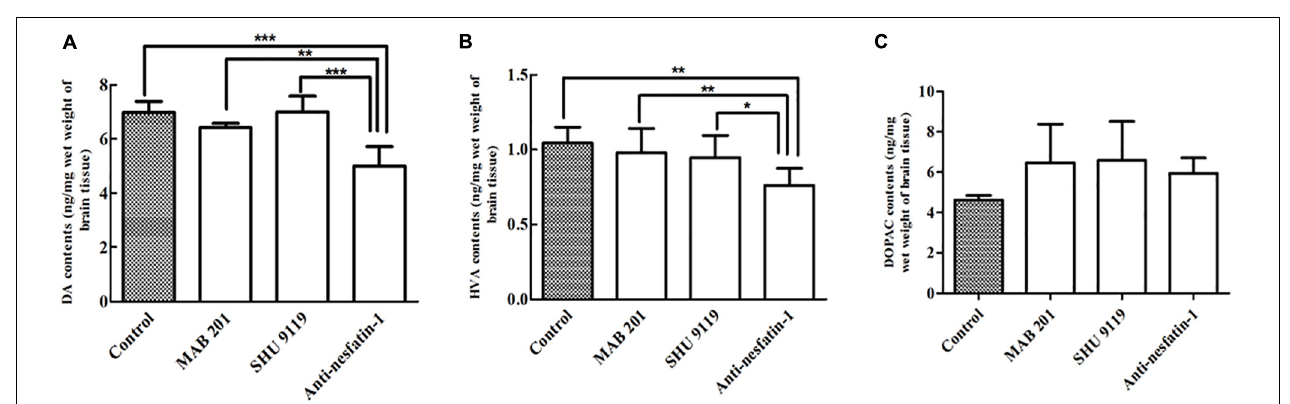
FIGURE 4 | Anti-nesfatin-1 antibody-induced depletion of DA and HVA in the striatum of the right brain ( n = 6). (A) Striatal DA levels in control mice and mice treated with MAB 201, SHU 9119, or anti-nesfatin-1 antibody are shown. (B) Striatal HVA levels in the different groups. (C) Striatal DOPAC levels in the different groups (DA, dopamine; HVA, homovanillic acid; DOPAC, dihydroxyphenylacetic acid). Each value represents the mean ± SD, n = 6; *** p < 0.0001, ** p < 0.005, and * p < 0.05. MAB 201, non-immune anti-mouse IgG antibody; SHU 9119, MC4R receptor